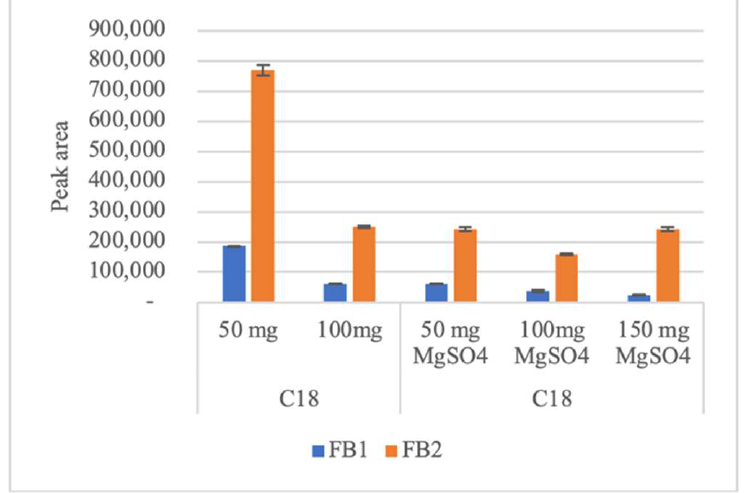
Figure 5. Average peak areas (n = 2) using octadecyl modified silica (C18) and magnesium sulfate (MgSO 4 ) in dispersive solid-phase extraction (d-SPE) for Fumonisins (FB1 and FB2).